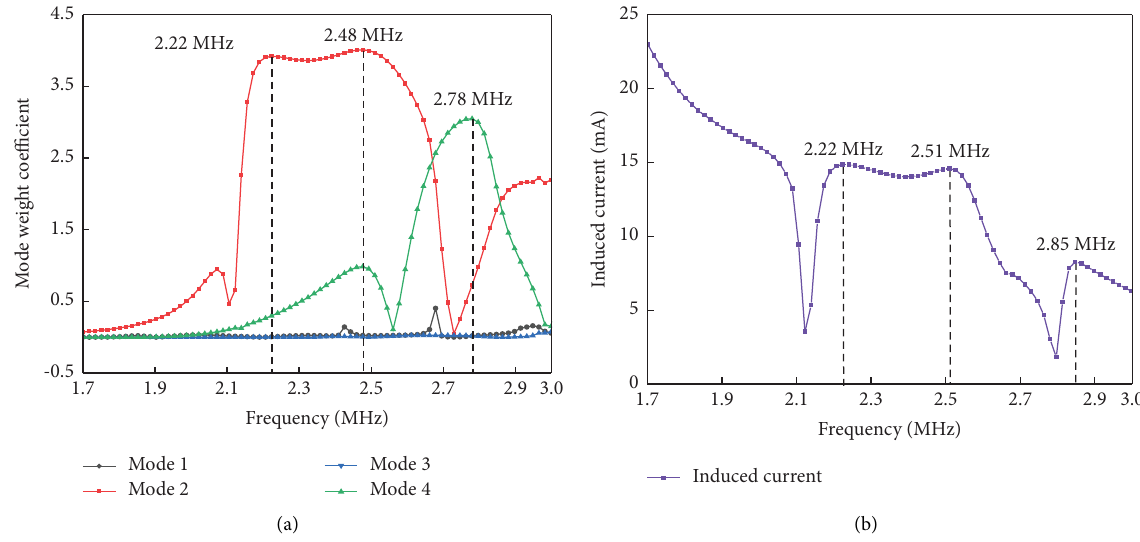
Figure 10: Variation with the frequency of mode weight coefcients and the induced current calculated by MoM. (a) Mode weight coefcients. (b) Te induced current calculated by